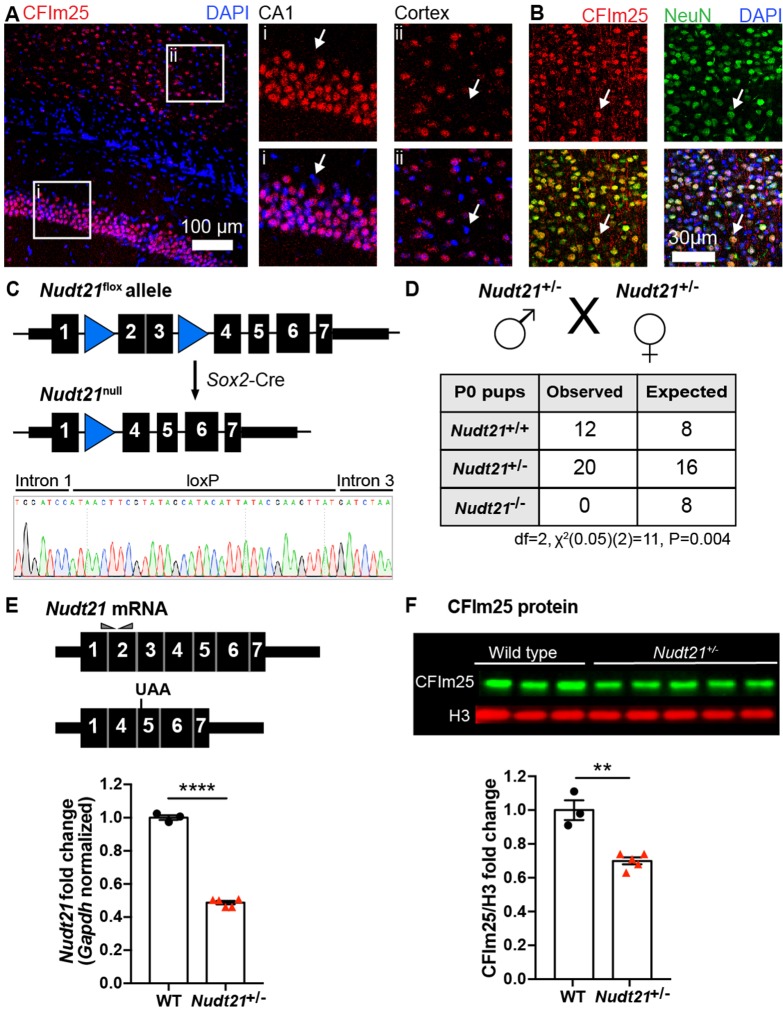
Nudt21 heterozygotes have 50% less Nudt21 mRNA in their neurons, but only 30% reduced CFIm25 protein.(A) Immunofluorescence showing CFIm25 expression in the nuclei of some cells in the (i) mouse hippocampus CA1 region and (ii) cortex. Arrows indicate nuclei that do not have CFIm25. (B) Immunofluorescence of the mouse cortex showing colocalization of CFIm25 and the neuronal marker NeuN. Arrows indicate a nucleus with CFIm25 and NeuN expression. (C) Schematic of the floxed and recombined Nudt21 alleles (top), and sequencing showing successful recombination (bottom). (D) Observed and expected offspring counts born with each possible genotype from Nudt21+/- mating pairs. No homozygous Nudt21 null offspring were born, when eight would be expected if loss of Nudt21 did not affect survival: p=0.004, analyzed by two-tailed, chi-square test. (E) Schematic of wild-type and recombined Nudt21 mRNA (top). Triangles indicate RT-qPCR primer binding sites, and UAA shows site of induced premature stop codon after recombination. RT-qPCR analysis shows expected 50% reduction of whole-brain, Gapdh-normalized, wild-type Nudt21 mRNA in five-week-old mice with one wild-type Nudt21 allele and one recombined, null allele (bottom): p<0.0001, n = 3–5/genotype. (F) Western blot image comparing five-week-old Nudt21+/- mice CFIm25 protein levels with their WT littermates (top). Western blot analysis showing ~30% reduction of H3-normalized CFIm25 protein levels in Nudt21+/- mice: p=0.0012, n = 3–5/genotype. We confirmed that CFIm25 does not regulate H3. For all charts, error bars indicate SEM. All data analyzed by unpaired, two-tailed t-test unless otherwise stated. **p<0.01; ****p<0.0001. Weights of the heterozygous animals are shown in Figure 1—figure supplement 1.